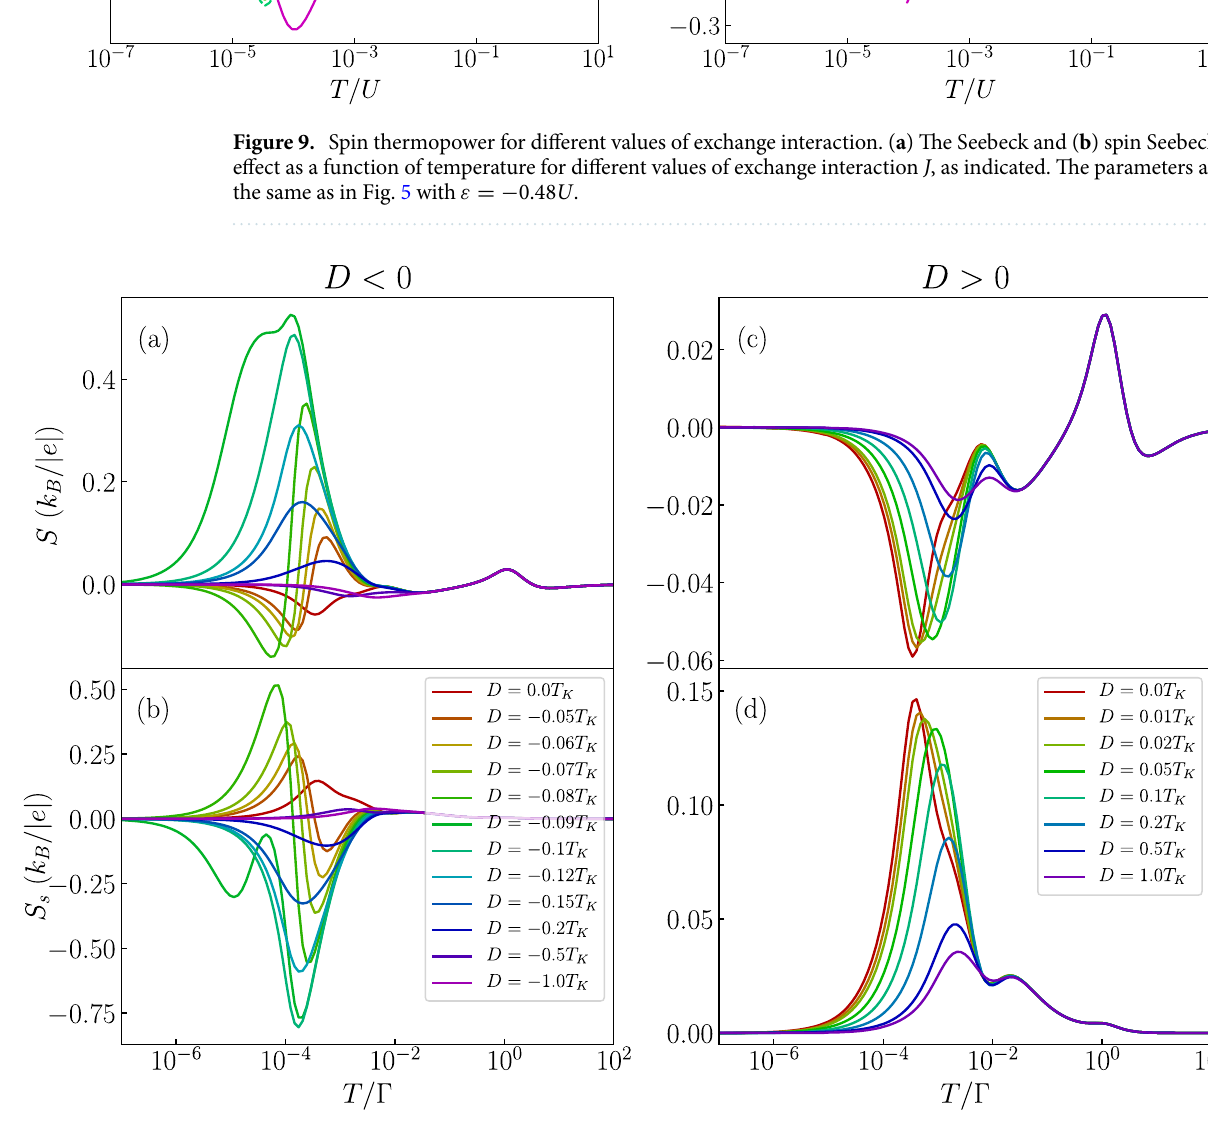
Figure 10. Spin thermopower for different values of magnetic anisotropy. The temperature dependence of ( a , c ) the thermopower and ( b , d ) the spin thermopower in the case of antiferromagnetic exchange interaction J = − T K for selected values of magnetic anisotropy D . The left (right) column presents the case of easy-plane (easy-axis) type of magnetic anisotropy. The parameters are the same as in Fig.